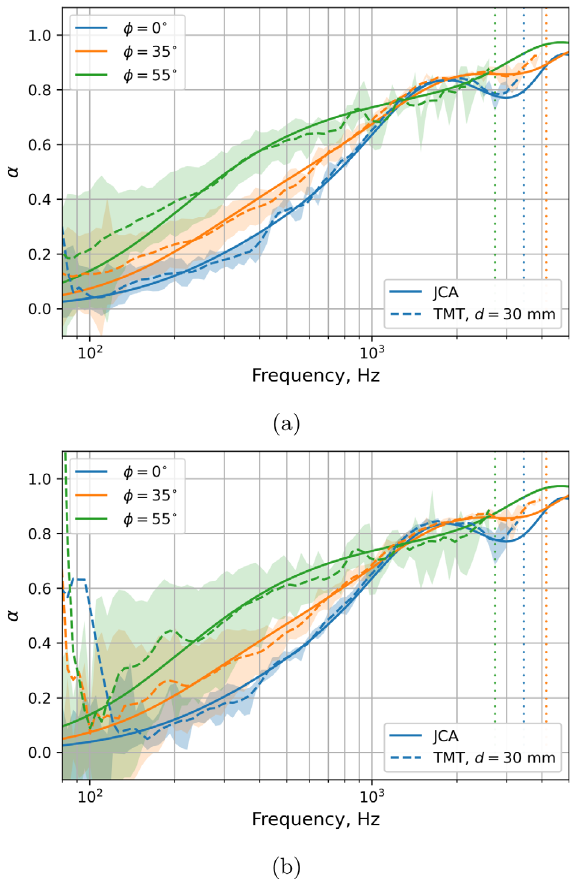
Figure 14. Mean absorption coef fi cient a (a), mean normalized surface impedance z s (b), calculated with 20 azimuth angles h 2 [0, 2 p ] for three incidence angles / and for the con fi guration shown in Figure 2 with a = 105 cm, b = 33 cm, D m (cid:7) 6.6 cm, k = 10 (cid:3) 9 , z a = 0.5 cm, d = 3 cm. The shaded areas indicate the variance of h 2 [0, 2 p ].